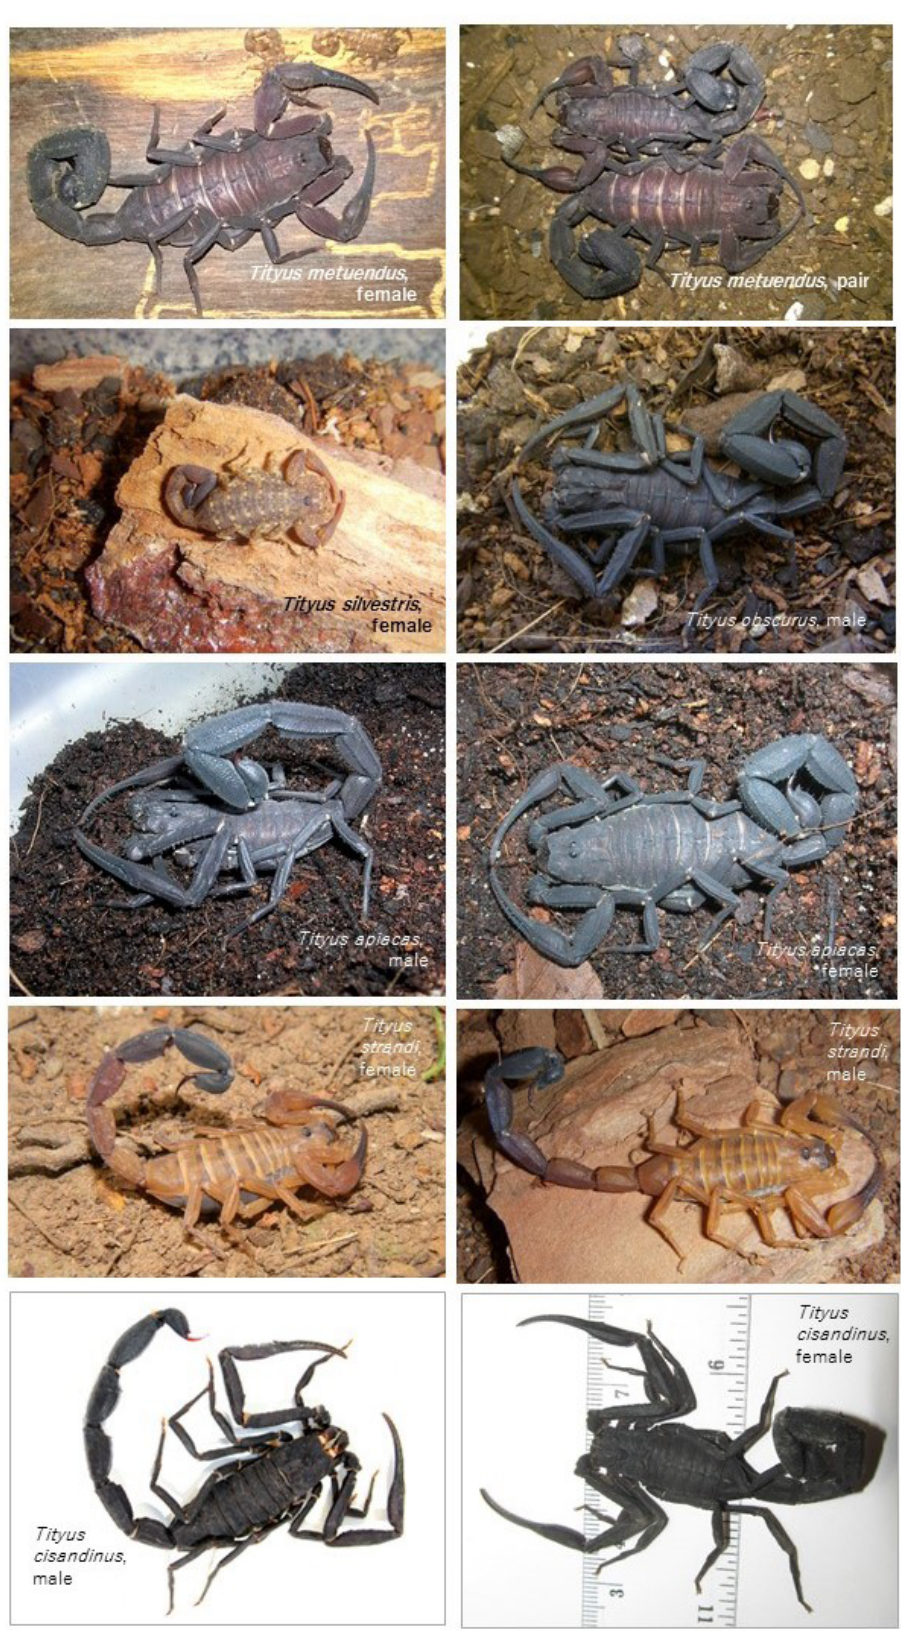
Figure 2. Representative Tityus species from Brazilian and Ecuadorean Amazonia. Photographs of Brazilian specimens by Denise Cândido, and those of T. cisandinus by Adolfo